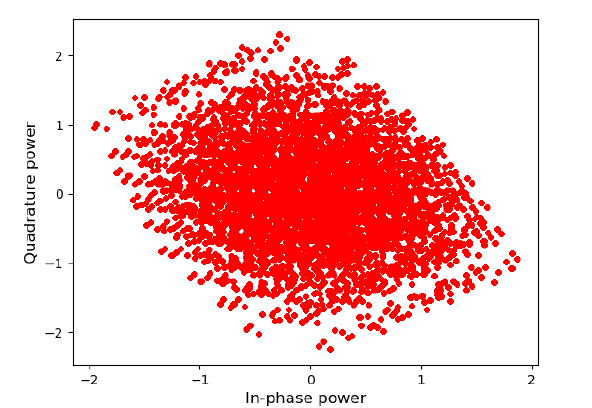
Figure 5. DSM constellation